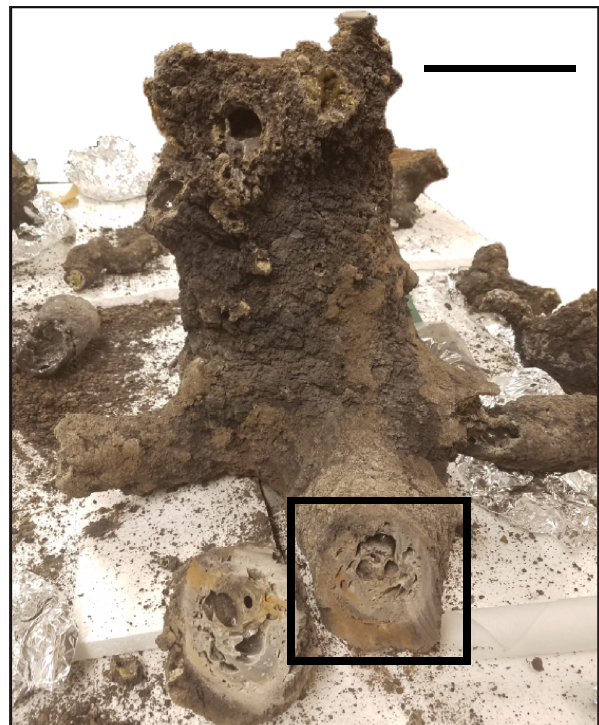
Fig. 1 Main section of a clay fulgurite created by lightning striking soil. The thick, glassy interior is coated in burnt soil. The black box indicates the location of the sample analysed in this study (Fig. 2a). Scale bar = 10